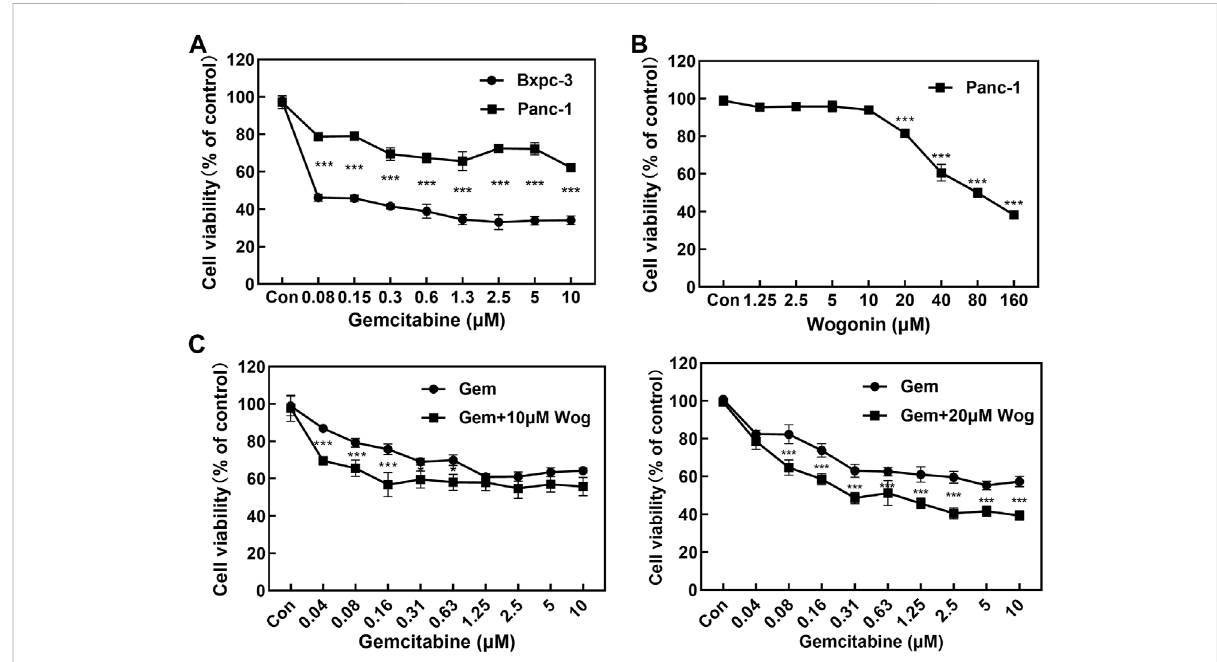
FIGURE 1 Wogonincombinedwithgemcitabineinhibitstheproliferationofpancreaticcancercells. (A) ThecellviabilityofPanc-1andBxpc-3cellstreated with gemcitabine was assessed using MTT assay at 72 h. Compared with Bxpc-3, Gemcitabine displayed no signi fi cant antiproliferative effects to Panc-1 cell. (B) The cell viability of Panc-1 treated with wogonin was assessed using MTT assay at 72 h. The cell viability decreased with the elevated concentration of wogonin. (C) Sensitizing effect of wogonin in Panc-1 cells to gemcitabine. Cells were treated with gemcitabine (0, 0.04, 0.08, 0.15, 0.3, 0.6, 1.3, 2.5, 5 and 10 μ M), Gem + Wog (10 μ M) and Gem + Wog (20 μ M) for 72 h and cell viability was determined by MTT assay. * p < 0.05, ** p < 0.01, *** p < 0.001 vs.